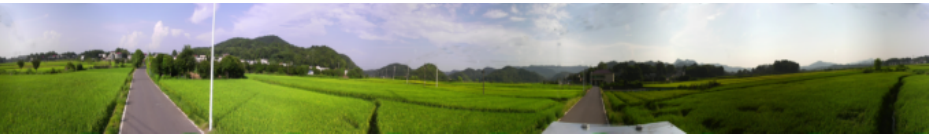
Figure 35. The panoramic image. Using the image stitch algorithm, the sub images in Figure 34 are merged into a panorama. The left side is the image captured when the optical axis of the camera coincides with the central axis of the